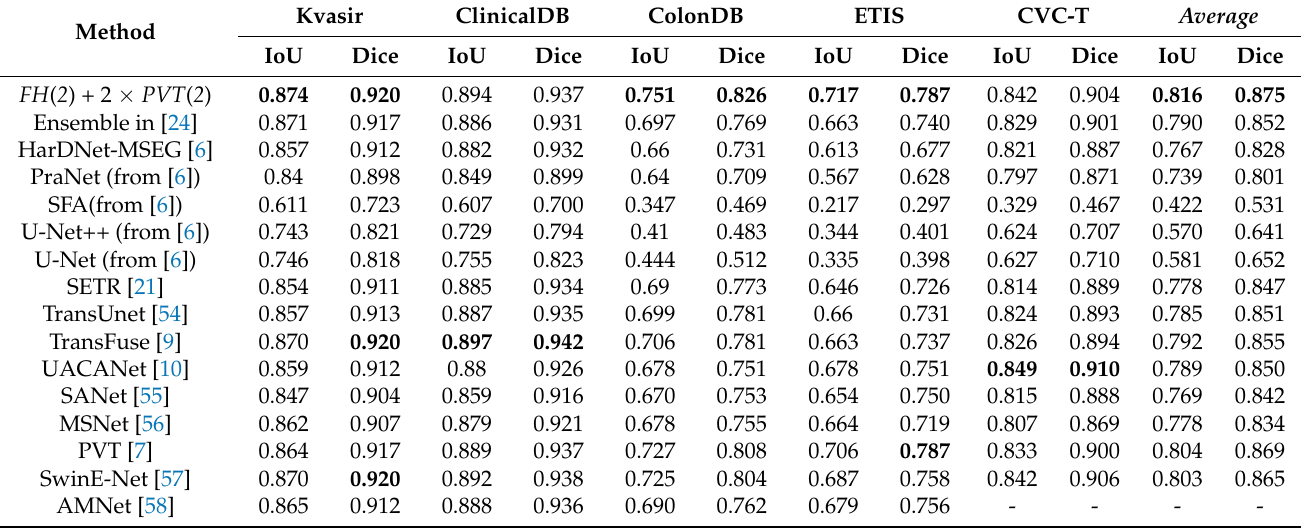
Table 5. Performance (dice and IoU) in the polyp segmentation problem. Best performance is marked in bold font.